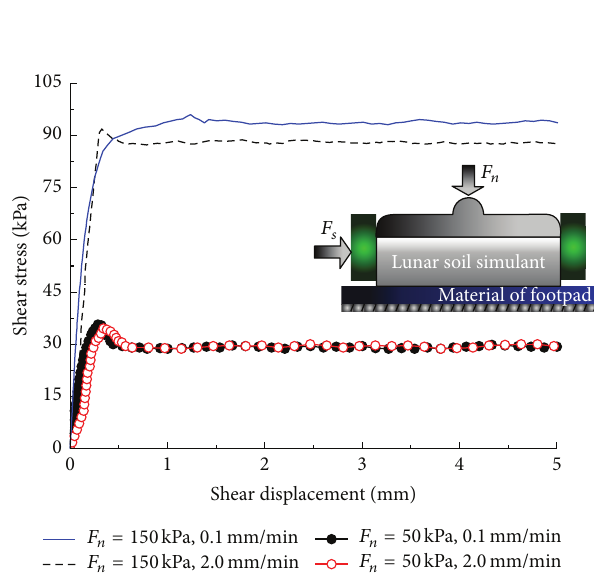
Figure 25: Shear test curves of soil-structure